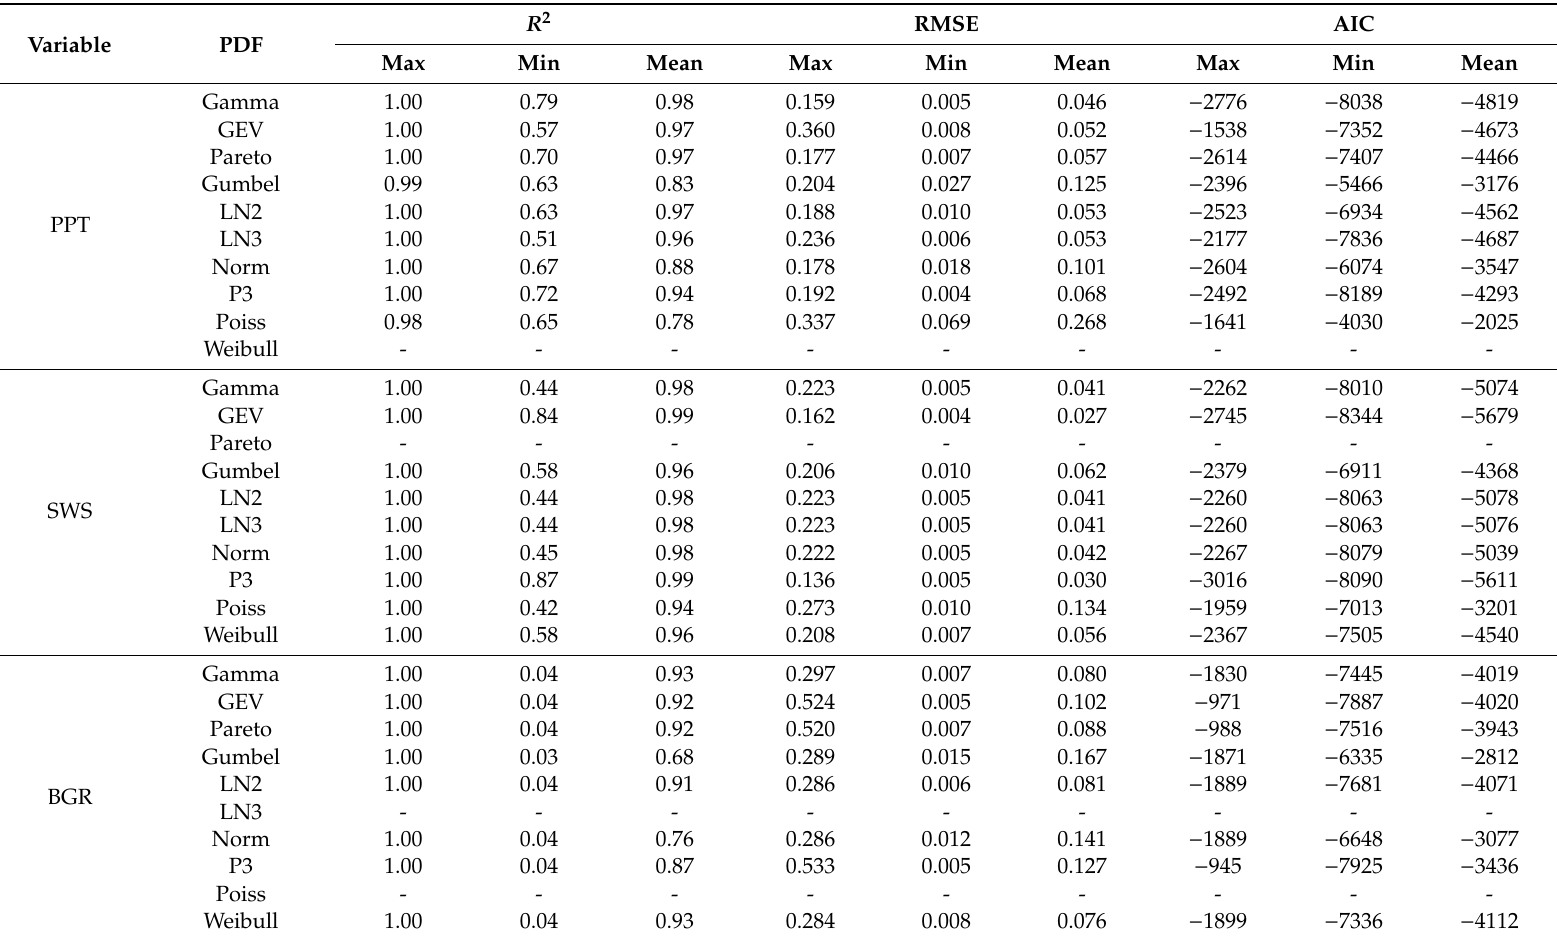
Table A1. Statistical parameters that showed the performance of ten PDFs fitting PPT, BGR and